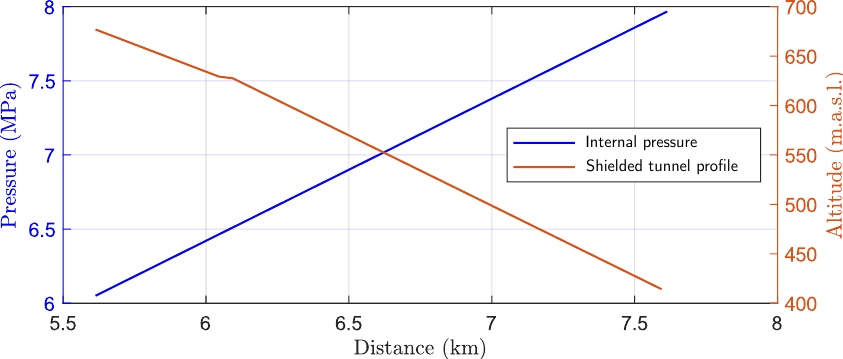
Figure 8. Internal pipe pressure for the structural design and pipe profile.